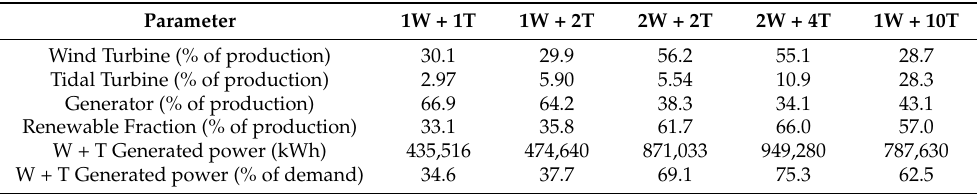
Table 12. Share of wind and tidal turbines in producing electricity and meeting demand.